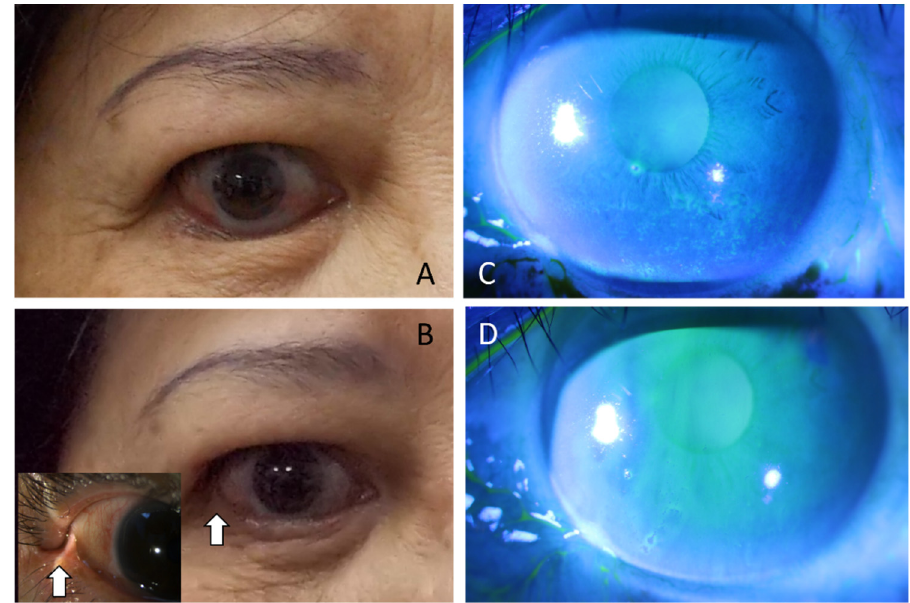
Figure 2. External ocular photos showed lower lid retraction with 2–3 mm scleral show and entropion ( A ). Three months postoperatively, entropion with retraction was corrected with LTF which was barely seen in the lateral canthus (pointed by arrowhead) ( B ). Diffuse superficial punctate kearatopathy was seen over middle to inferior third of the cornea surface before LTF surgery ( C ). Three months postoperatively, the cornea surface was recovered without apparent corneal damage noted ( D ) (Different patients between ( A , B ) and ( C , D